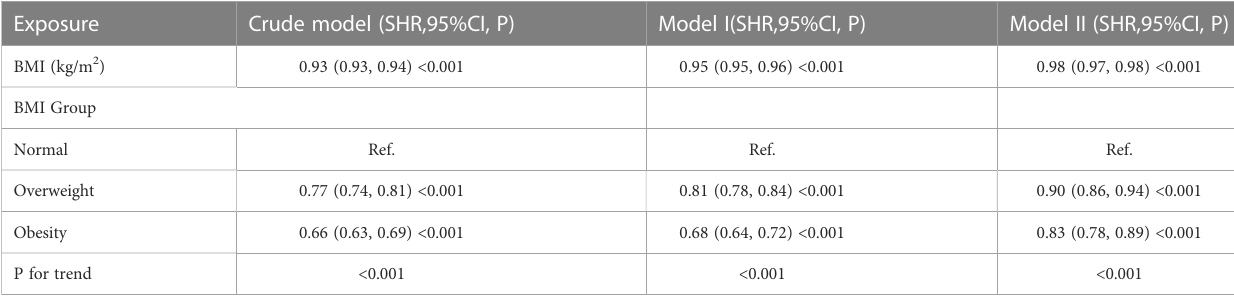
TABLE 5 Relationship between BMI and reversion to normoglycemia in patients with IFG in different models with competing risk of progression to diabetes. Exposure